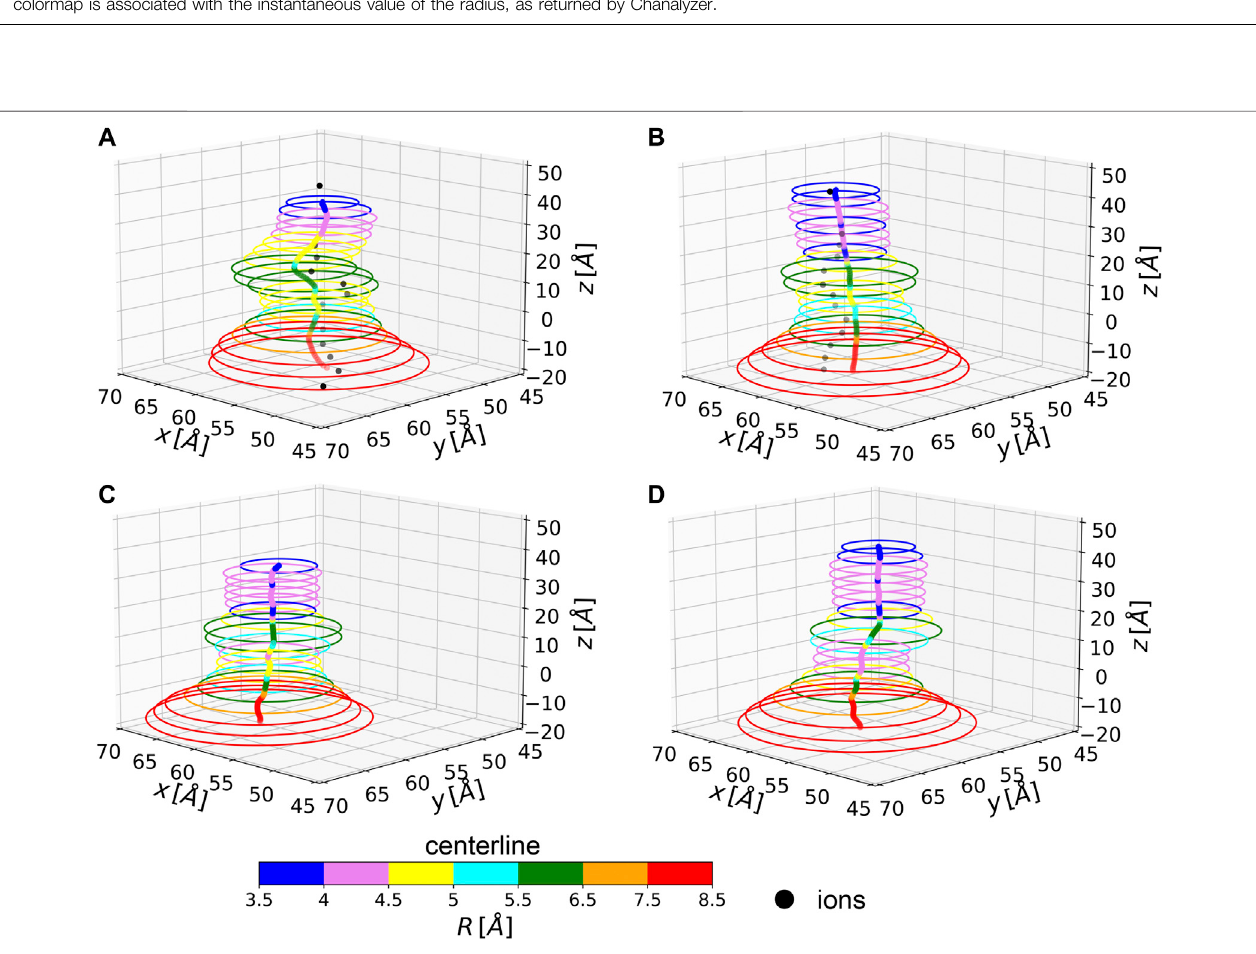
FIGURE4| Averagecenterlines.Colorscodeforthesizeoftheassociatedradius.Blackdotsareaverageionpositionsforthepermeatingcon fi gurations.Fromtop to bottom and left to right: (A) NL, (B) 1L, (C) 3L, and (D) 5L.